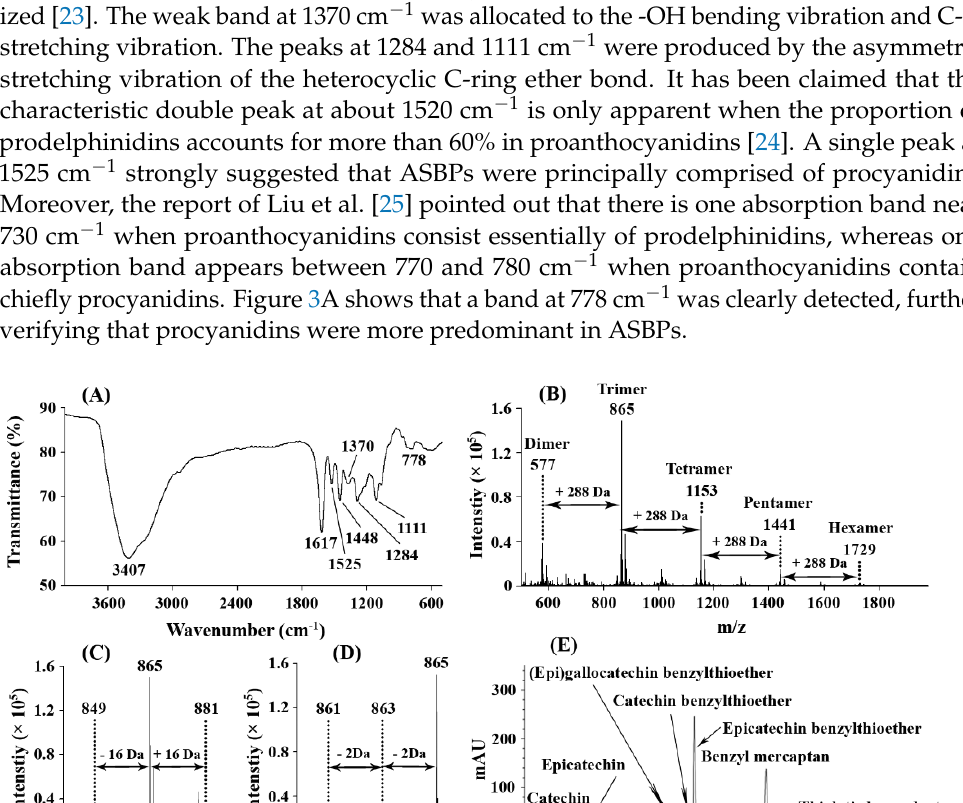
Figure 2. ( A ) UV-vis spectra of ASBPs and ( B ) their alcoholytic products. The inset images denote the colors of the samples before and after alcoholysis.